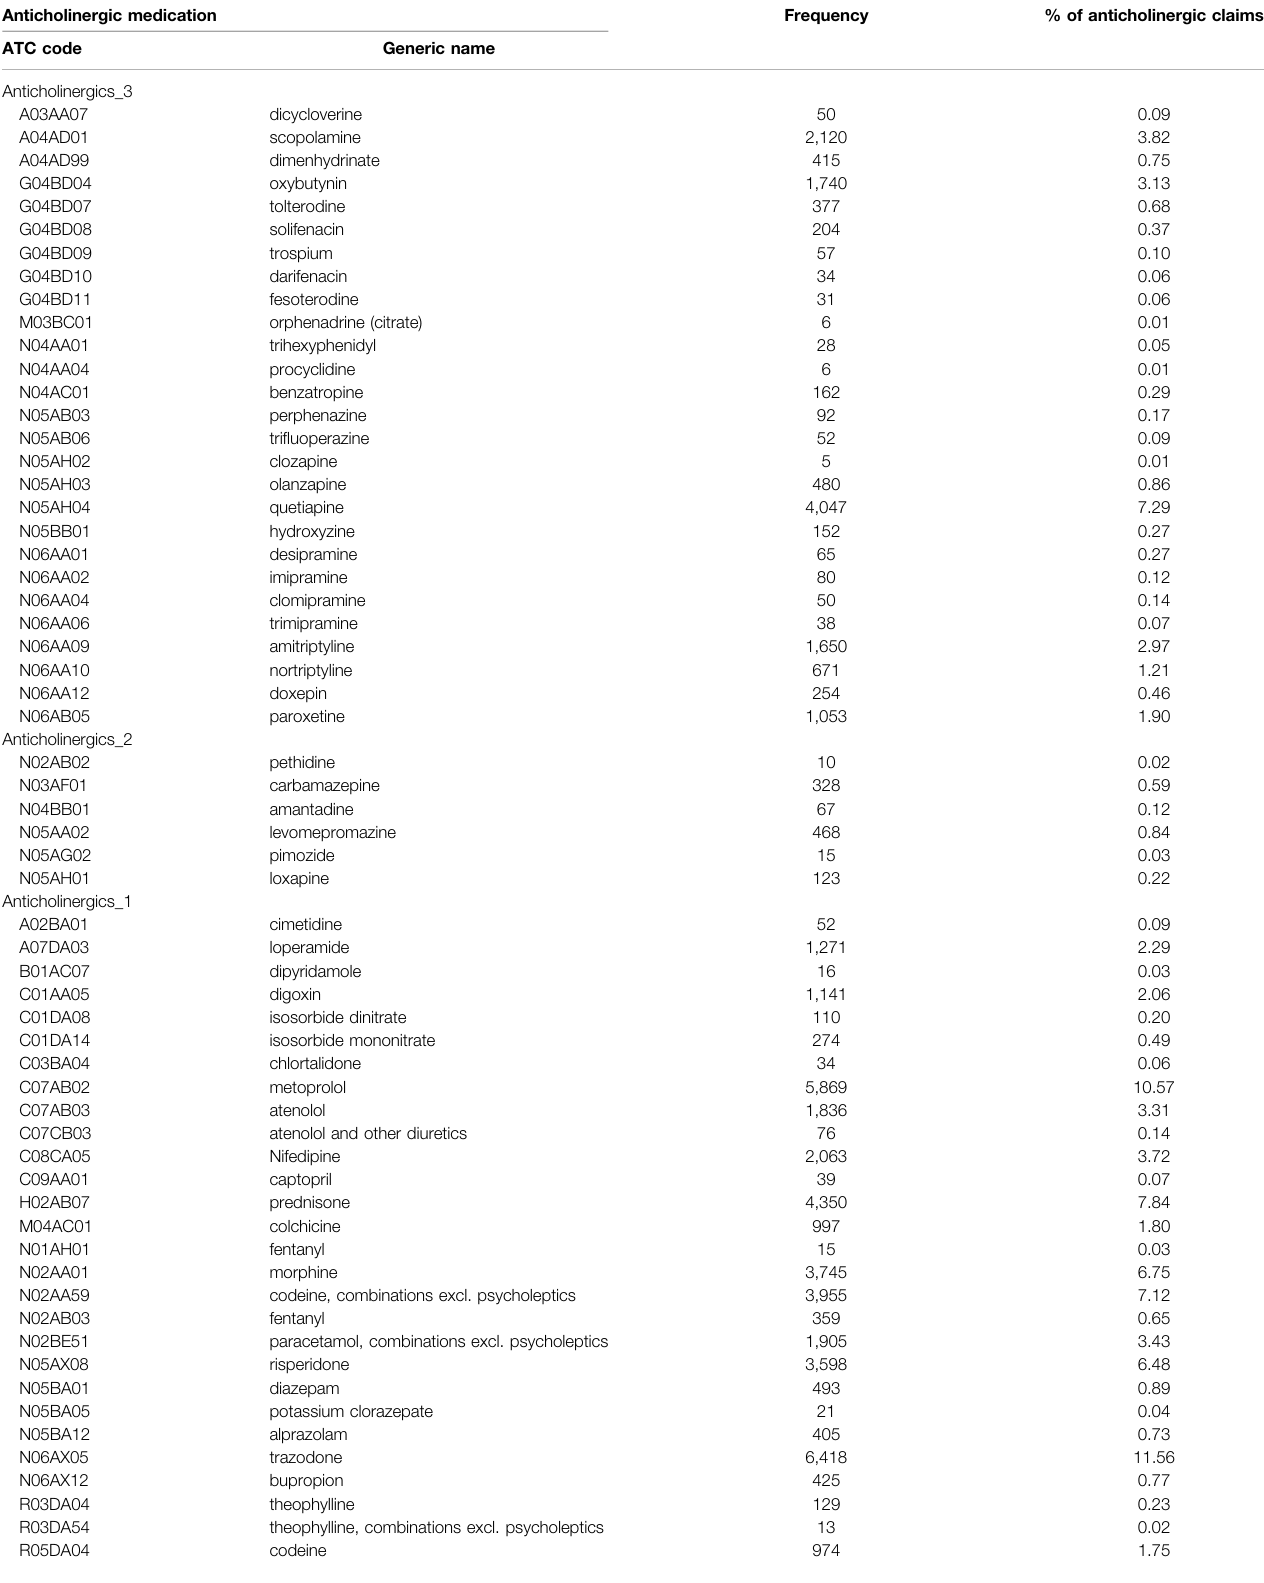
TABLE A1 | Anticholinergic Cognitive Burden Scale Medications dispensed to the cohort of Nova Scotia Seniors ’ Pharmacare Bene fi ciaries with Dementia. Anticholinergic